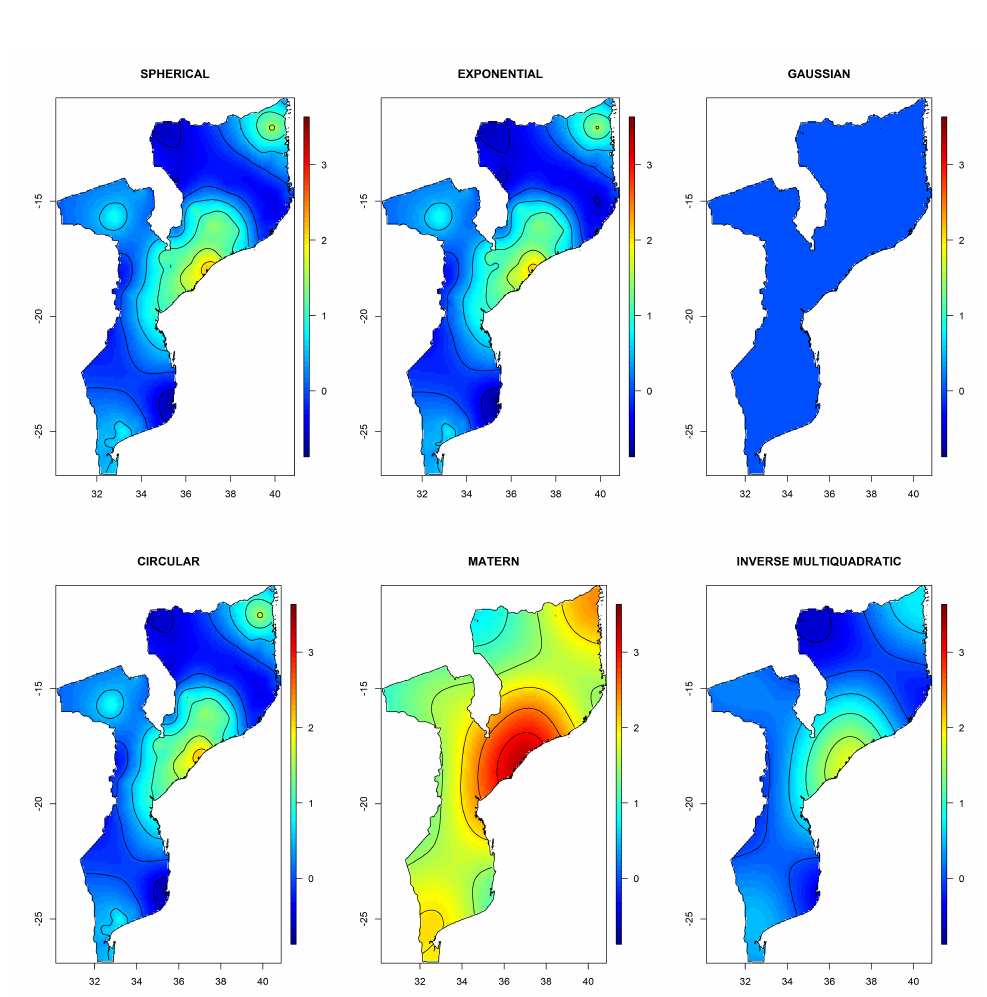
(cid:107) s − s (cid:107) under different covariance i j 1 ≤ i , j ≤ n